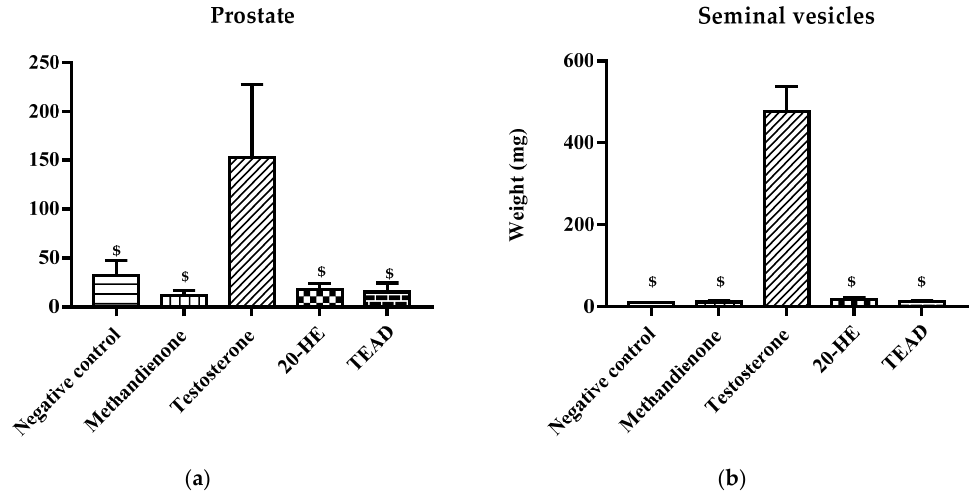
Figure 9. Mass of prostate ( a ) and seminal vesicles ( b ) of treated groups. $ : Significantly different from the testosterone group at p < 0.0001.